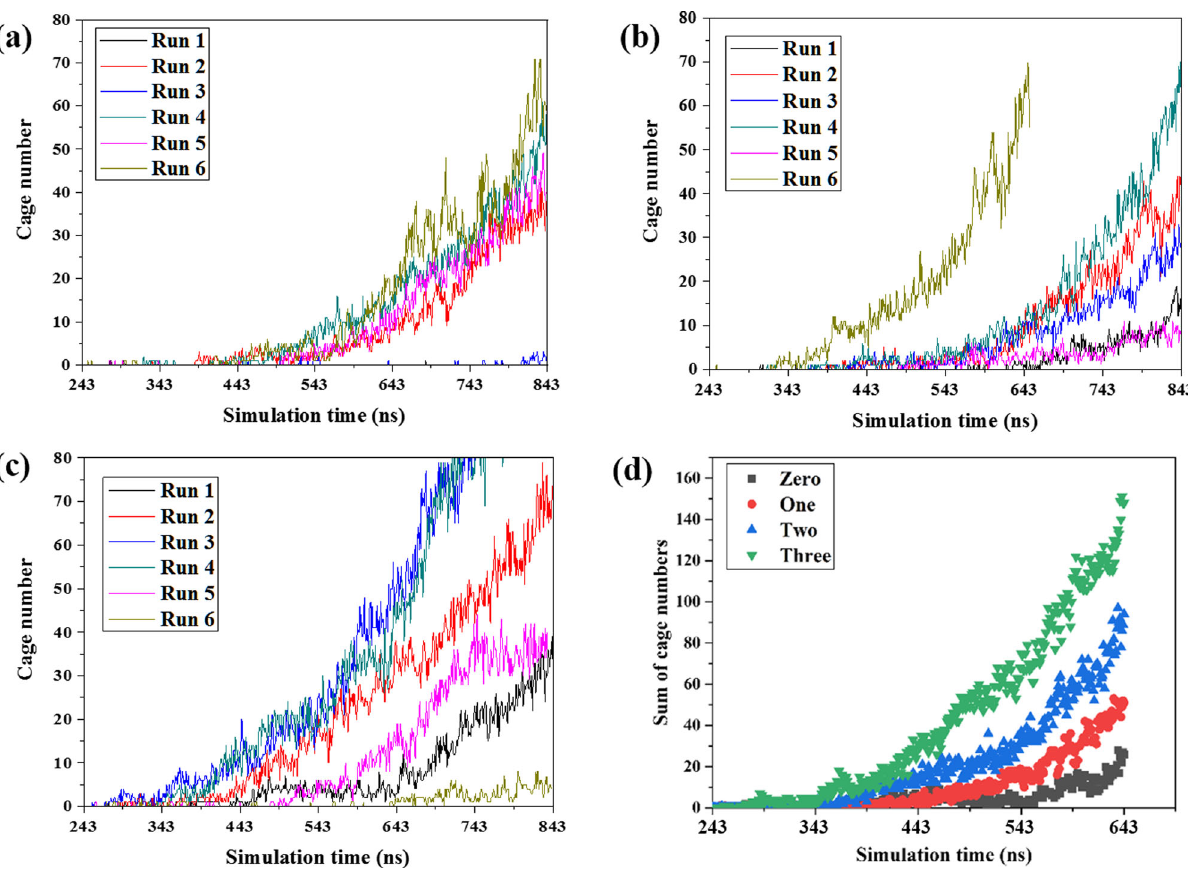
Fig. 8 Acceleration of three-body aggregates on hydrate nucleation and growth. The total cage numbers were calculated and the results for one, two, and three three-body aggregates systems are illustrated in ( a – c ), respectively. d The cage numbers for the six independent runs were summed and compared for systems with zero, one, two, and three